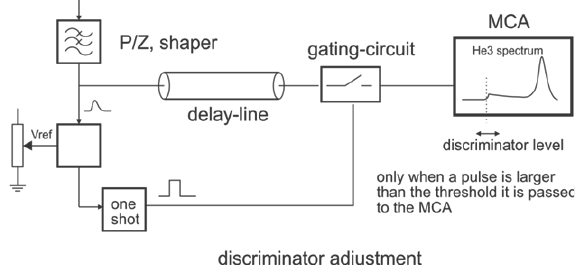
Fig. 3. Adjustment of the discriminator threshold.